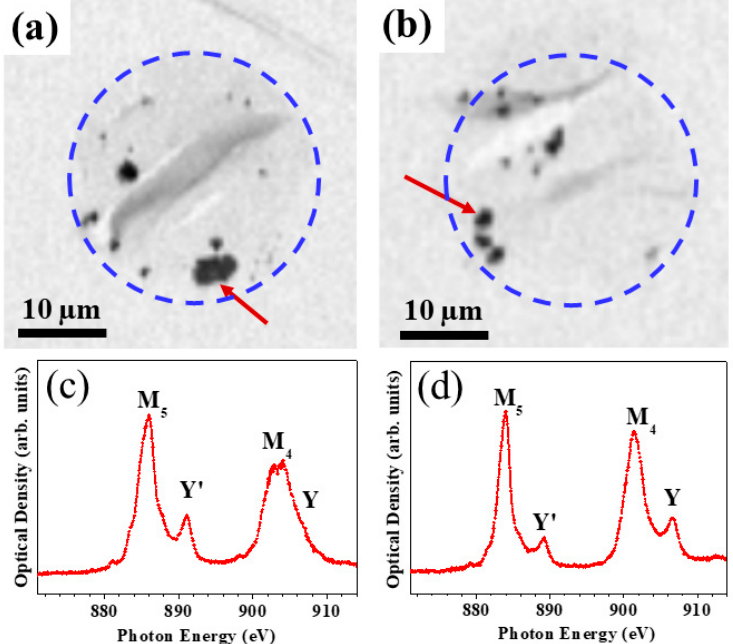
Figure 3. STXM images ( a , b ) and the XAS data ( c , d ) obtained for Cr@CeO x nanoparticles (NPs) ( a , c ) and Fe@CeO x NPs, which are shown in black (see the arrow position).